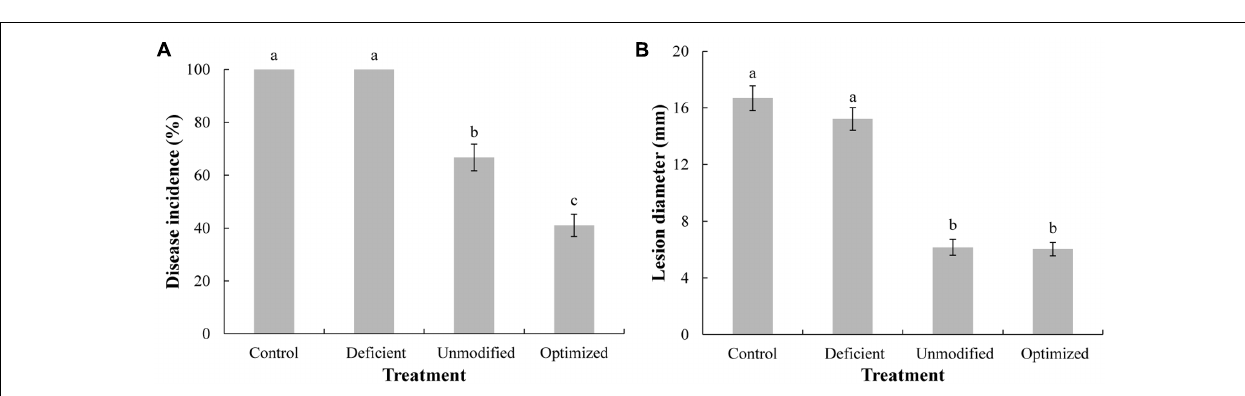
FIGURE 5 | Biocontrol efficacy of C. diversa against Botrytis cinerea on apple fruit. Prior to use, yeast were grown for 96-h in three different media: unmodified minimal media (MM), ion-deficient MM, and Mg 2 + , Fe 2 + , and Zn 2 + optimized MM. Control: sterile water plus B. cinerea spores, without C. diversa . Disease incidence (A) and lesion diameter (B) in apple fruits were measured 4 days after inoculation. Data represent the mean ± SD of the pooled data from three experiments ( n = 9). Columns with different letters indicate significant differences according to a Duncan’s multiple range test ( P <